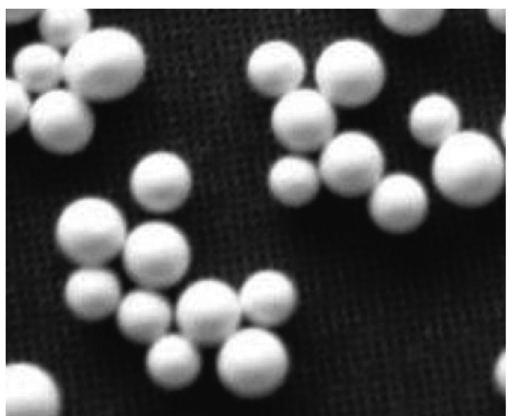
FIGURE 1 - Photograph of stearic acid coated pellets.